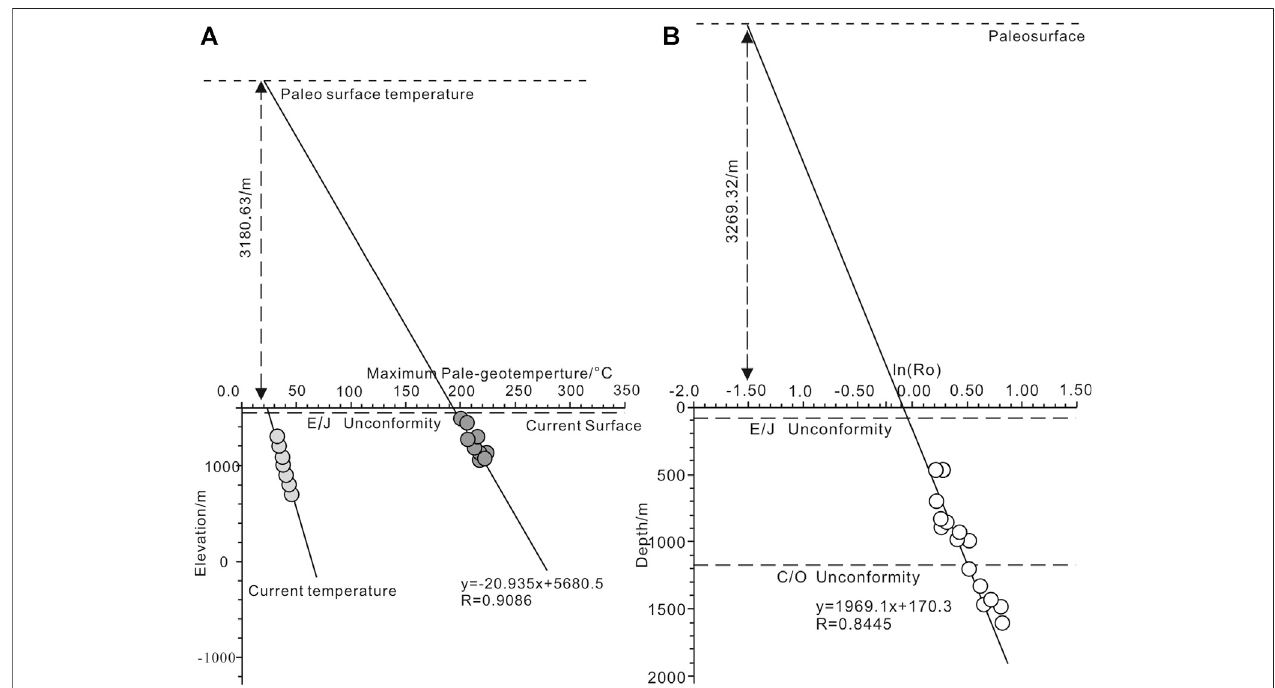
FIGURE 9 | Denudation thickness of central Qinshui Basin (A) Denudation thickness restored by illite crystallinity. (B) Denudation thickness of Qincan 1 well restored by ln ( R o ).